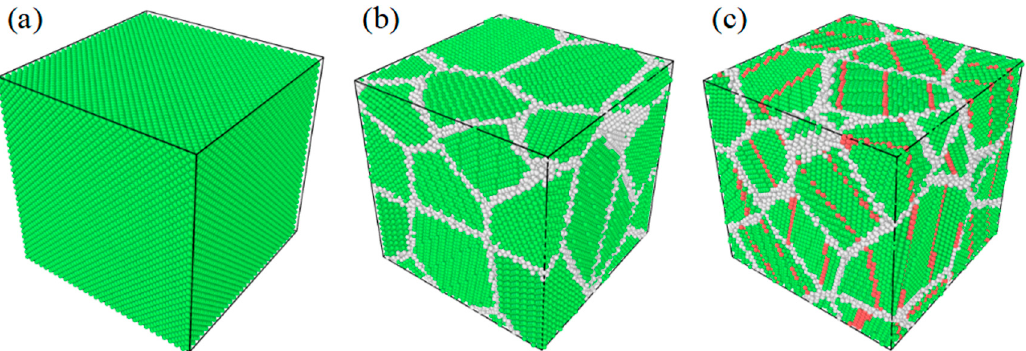
Figure 1. CoCrNi MEA model of FCC phase simulated by MD. ( a ) SC, ( b ) polycrystal, ( c ) polycrystal with TB spacing λ = 1.83 nm. FCC atoms are colored green, GBs are colored white, TBs are colored